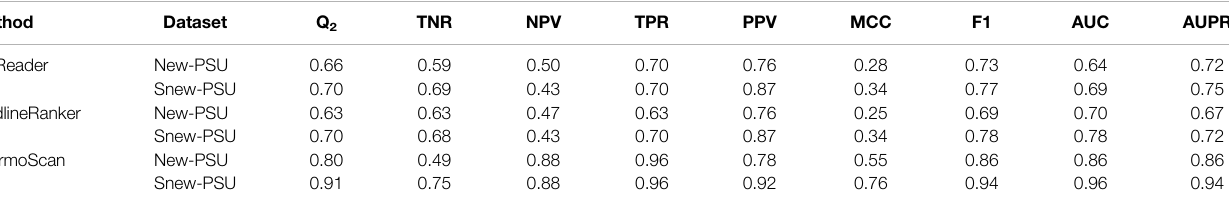
TABLE 3 | Comparison of the performance of ThermoScan (based on maximum paragraph/table score) with BioReader and MedlineRanker on the New-PSU and Snew- PSUdatasets.Theclassi fi cationthresholdsforBioReaderandMedlineRankerandThermoScanare0.022,0.027andthreerespectively.Theperformancemeasuresare de fi ned in Supplementary Materials